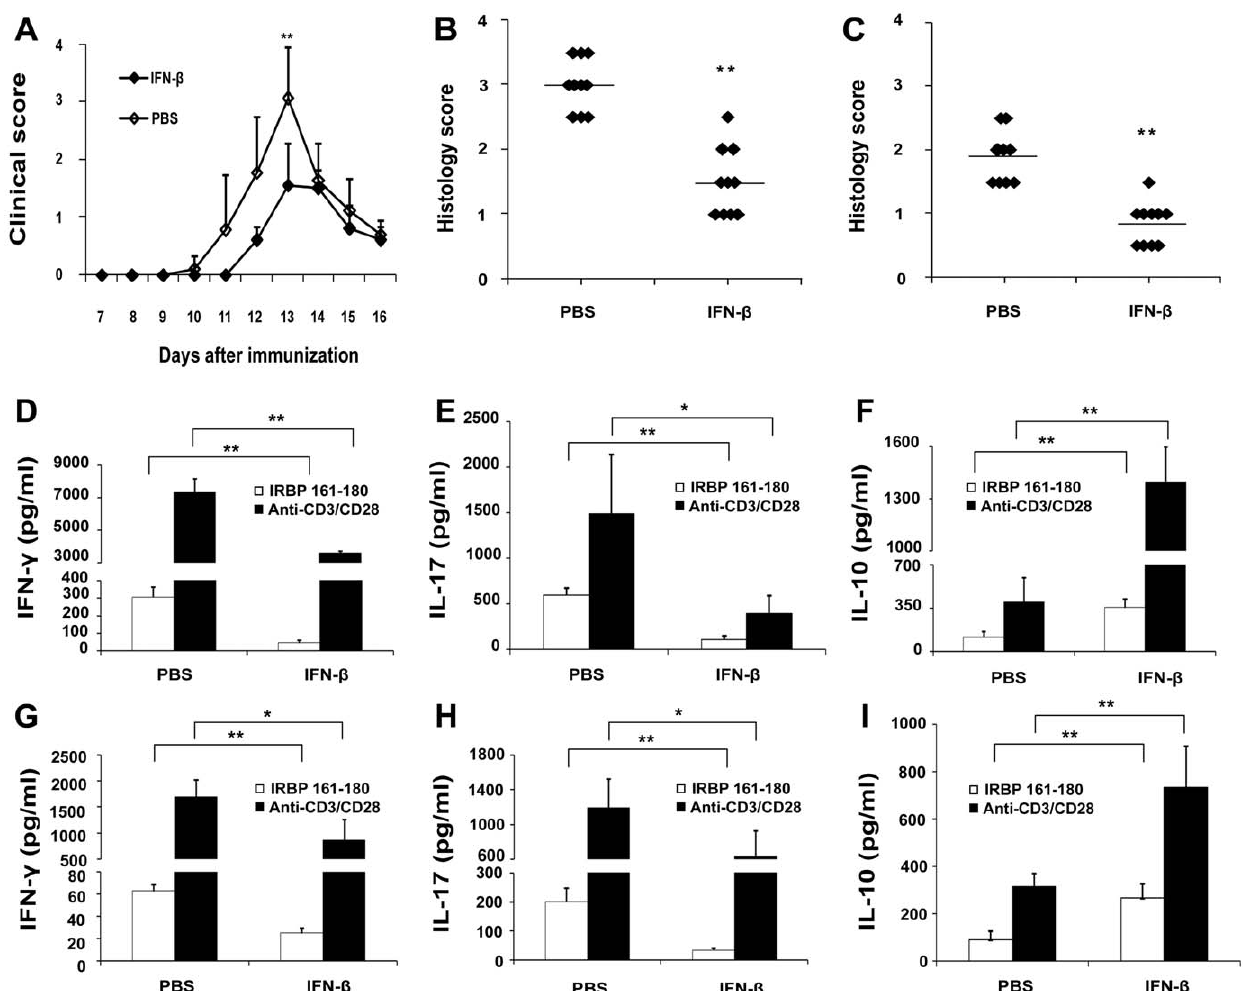
Figure 3. The influence of IFN- b treatment on EAU activity, production of IFN- c , IL-17 and IL-10. Clinical scores (A) and histology scores on day 13(B) and day 16 (C) of IFN- b or PBS treated EAU mice. Splenocytes (D-F) and DLN cells (G-I) from day 16 with or without IFN- b treatment were activated with IRBP 161-180 (20 m g/ml) or anti-CD3 and anti-CD28 (1 m g/ml) for 72 hours. Cytokines were analyzed by ELISA. Data are representative of three independent experiments with at least five mice per group. **p , 0.01, *p , 0.05.